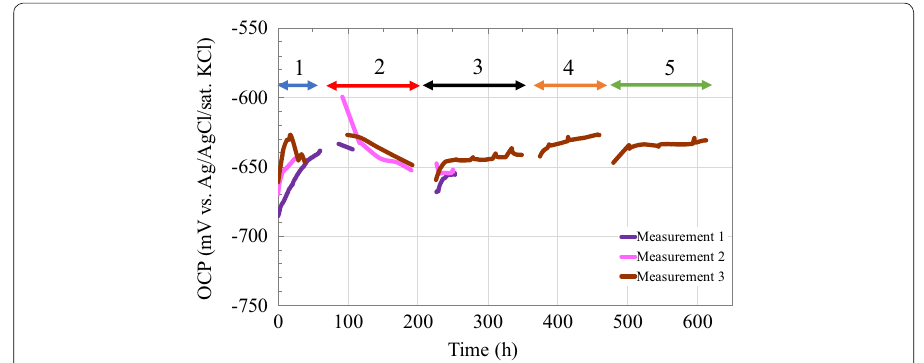
Fig. 4 Open circuit potentials (OCP) of the API steel sample L80 measured over time. Three independent measurements were carried out for the testing solution investigated